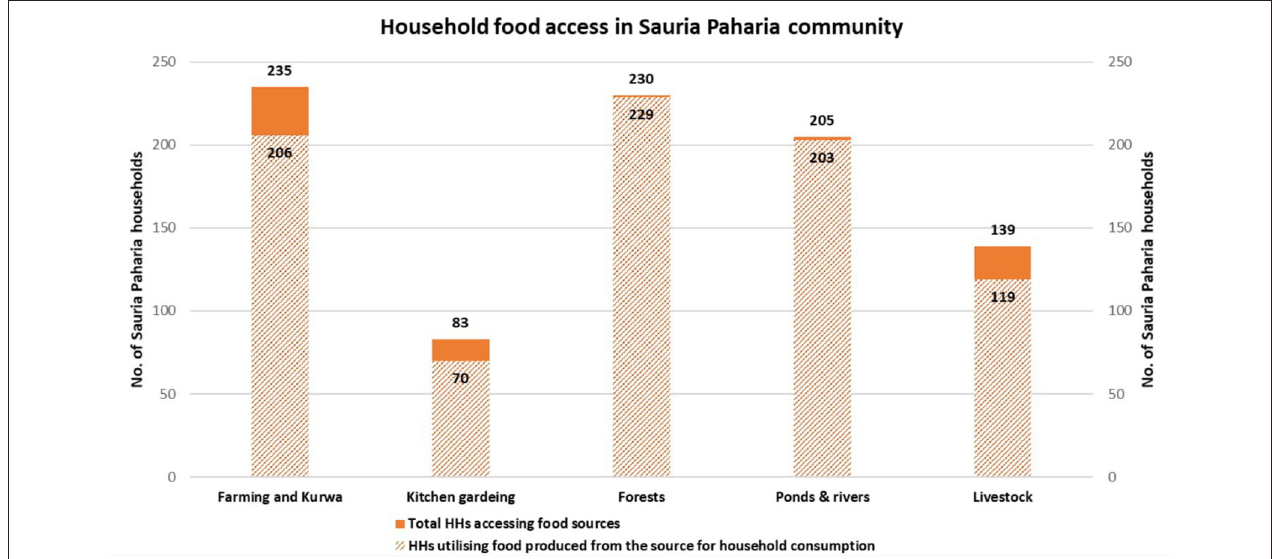
FIGURE 3 | Household food access from natural sources in Sauria Paharia community ( n = 246). *Kurwa refers to utilization of small patches of forest lands for slash and burn cultivation.